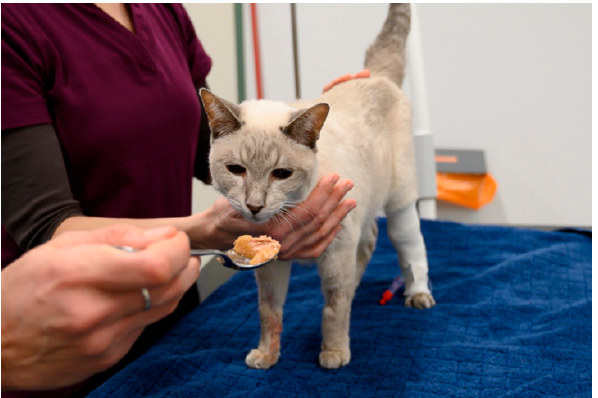
Figure 4. Use of high-value food (or toys) can increase cooperativeness and promotes positive emotions. Photo: Christine Arhant, Vetmeduni Vienna.